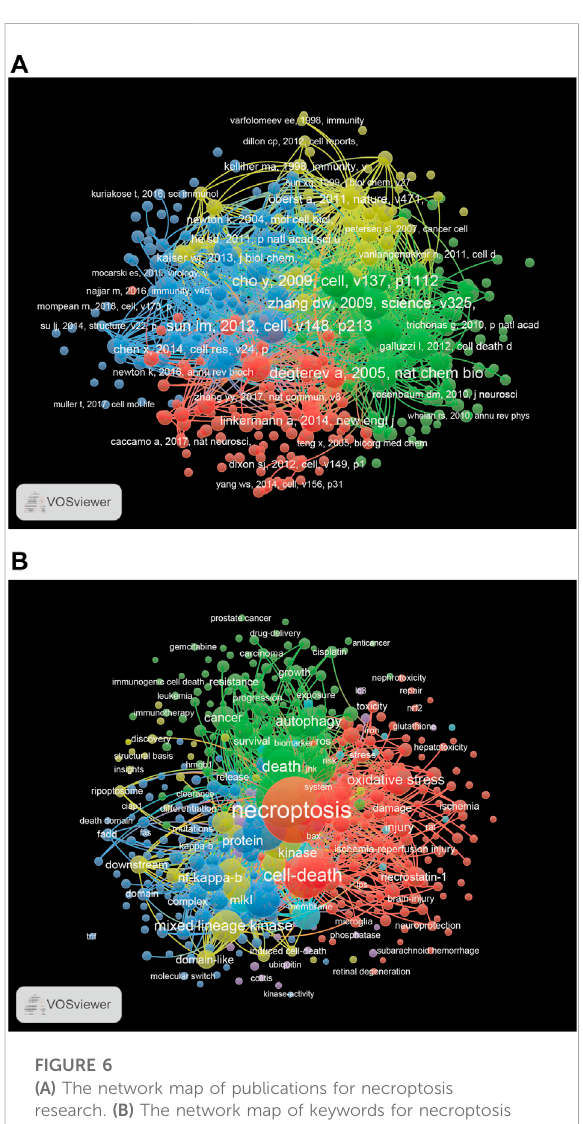
FIGURE 6 (A) The network map of publications for necroptosis research. (B) The network map of keywords for necroptosis research.